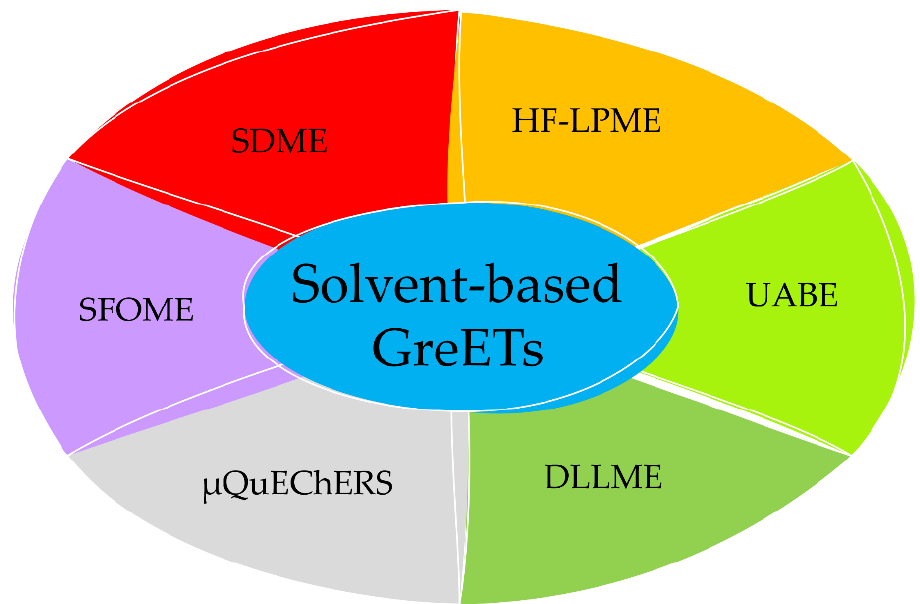
Figure 4. Different liquid ‐ based GreETs used in several fields of analysis. Legend: DLLME: dispersive liquid–liquid microextraction; GreETs: green extraction techniques; HF ‐ LPME: hollow fiber liquid ‐ phase microextraction, SDME: single ‐ drop microextraction; SFOME: solidification of floating organic drop microextraction; UABE: ultrasound ‐ assisted back extraction; μ QuEChERS: micro ‐ QuEChERS.